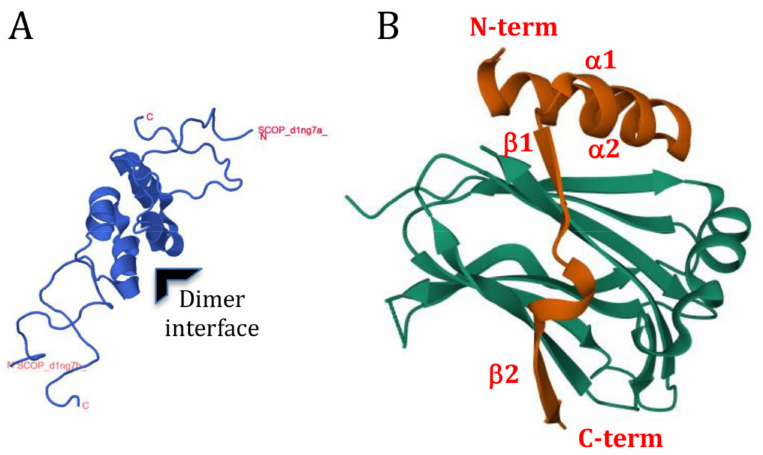
Figure 3. Structure of PV 3A. ( A ) The NMR structure [104] of a PV 3A (aa 1–59) dimer shown as a cartoon representation (PDB 1NG7). The central region of each 3A forms two amphipathic α helices Table 1. PV 3A (red) in a complex with the Golgi Dynamics (GOLD) domain of ACBD3 (green). Electron density could not be assigned for residues 1–14 of 3A. ( B ) In the complex, 3A formed four secondary elements (two α helices, α 1, aa 19–29, and α 2, aa 32–41, and two β strands, β 1, aa 44–46, and β 2, aa 53–58), which all make contacts with the GOLD domain (PDB 6HLV). 3A is wrapped around the GOLD domain so that the N- and C-termini of the N-terminal domain make contacts on opposite sides [107]. As in the nuclear magnetic resonance (NMR) structure, hydrophobic residues of α 1 and α 2 interact with the hydrophobic residues of the other 3A molecule that form the 3A dimer interface. When bound to ACBD3, dimerization of 3A drives formation of a 3A:ACBD3 heterotetramer. This allows for the membrane binding regions of the 3A molecules to “staple” ACBD3 to membranes at the RO (see [107] for